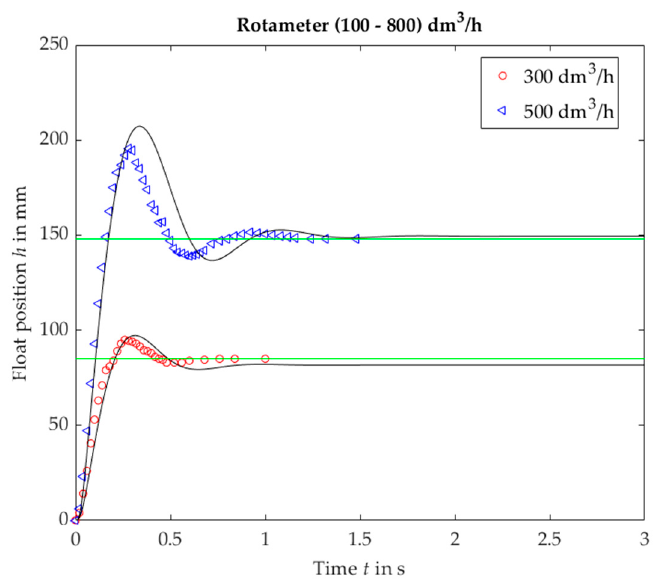
Figure 8. Rotameter no. 3, plumb bob. Float position h vs. time t for a step response, experimental (black solid lines) and calculated (markers).